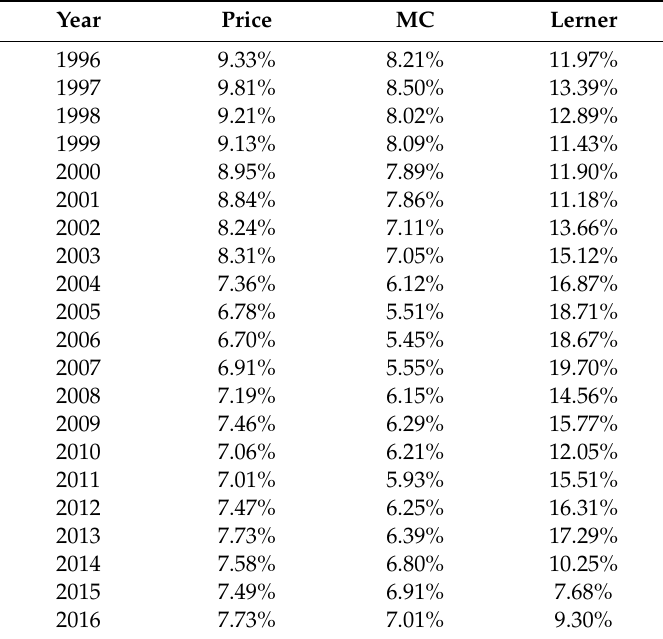
Table 7. Adjusted Lerner: